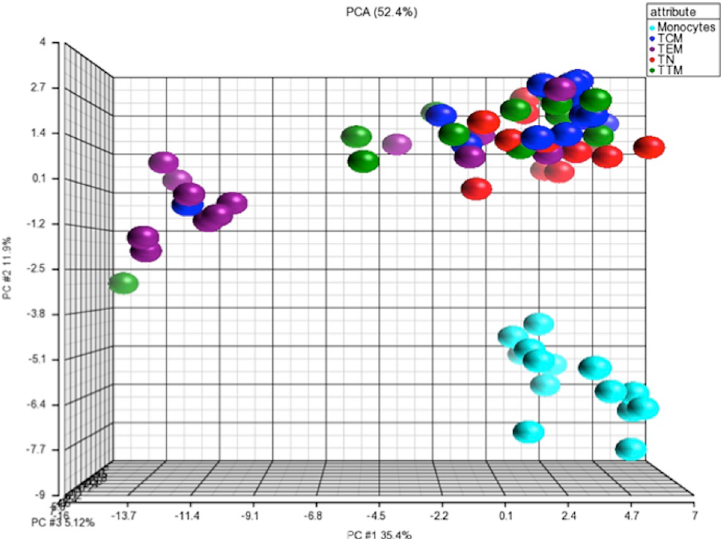
Fig 6. Transcriptomic analysis: A broad multiplex transcriptional profiling analysis of 96 genes was performed in monocytes (CD3-CD4-CD14+) and resting CD4 T-cells subsets: Naive (TN; CD45RA+CCR7+CD27+) central- memory (TCM; CD45RA-CCR7+CD27+) transitional memory (TTM; CD45RA-CCR7-CD27+) and effector- memory cells (TEM; CD45RA-CCR7-CD27-) from 14 HIV-2 infected subjects. A principal component analysis (PCA) plot representation of gene expression profile in each population is